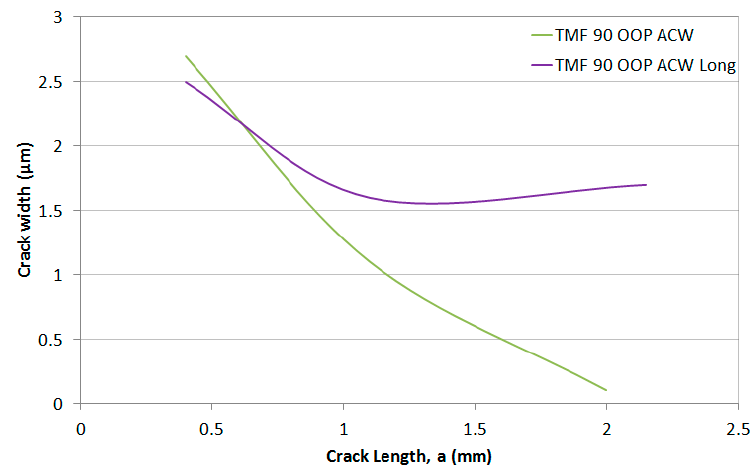
Figure 19. Crack width plotted against crack length for both 90° OOP ACW tests during stage 4 of the crack (TMF test).